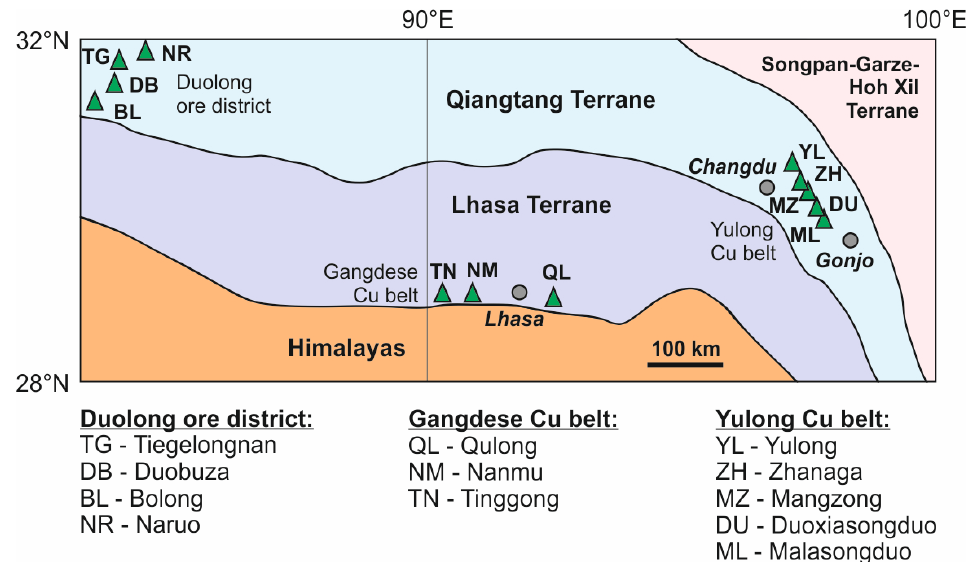
Figure 20. Distribution of major adakite-hosted Cu (Au, Mo) porphyry deposits (triangles) in Tibet. (Eastern Tethyan Belt). Crustal terrane nomenclature and geometry is after [263,268].